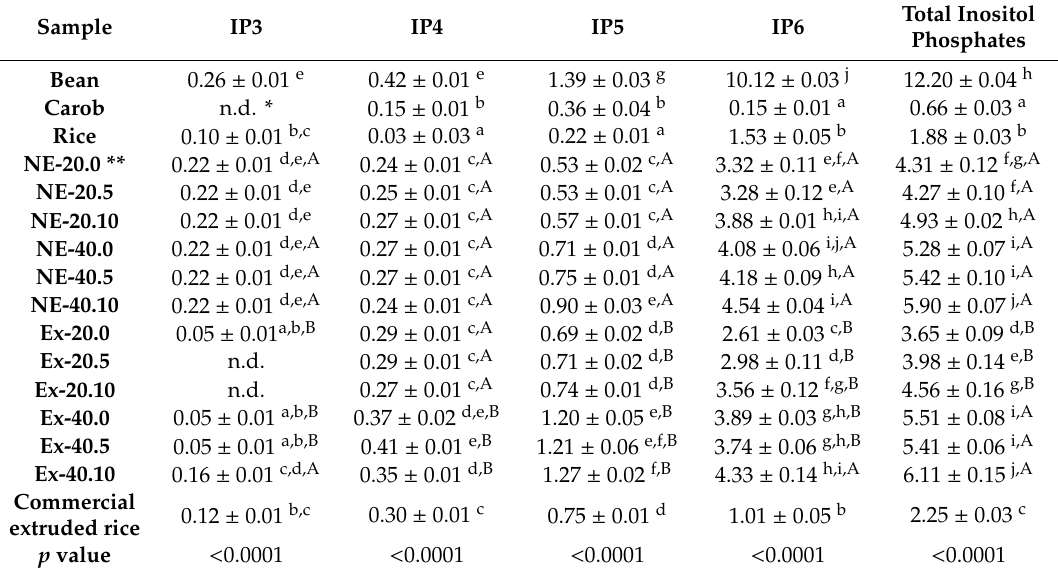
Table 2. E ff ect of extrusion treatment on the inositol phosphate content (mg / g dry weight) of raw materials, the non-extruded (NE-) and the extruded (Ex-) flour formulations, and the commercial